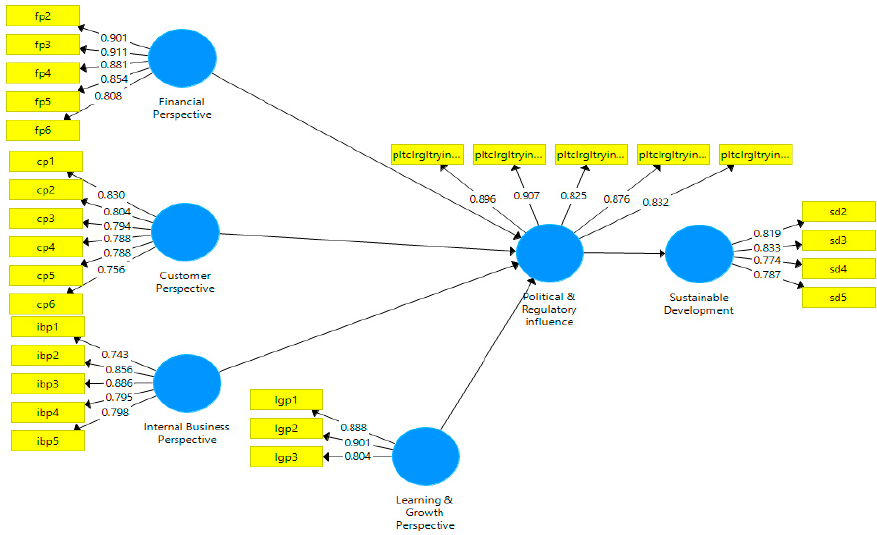
Figure 2. Factor